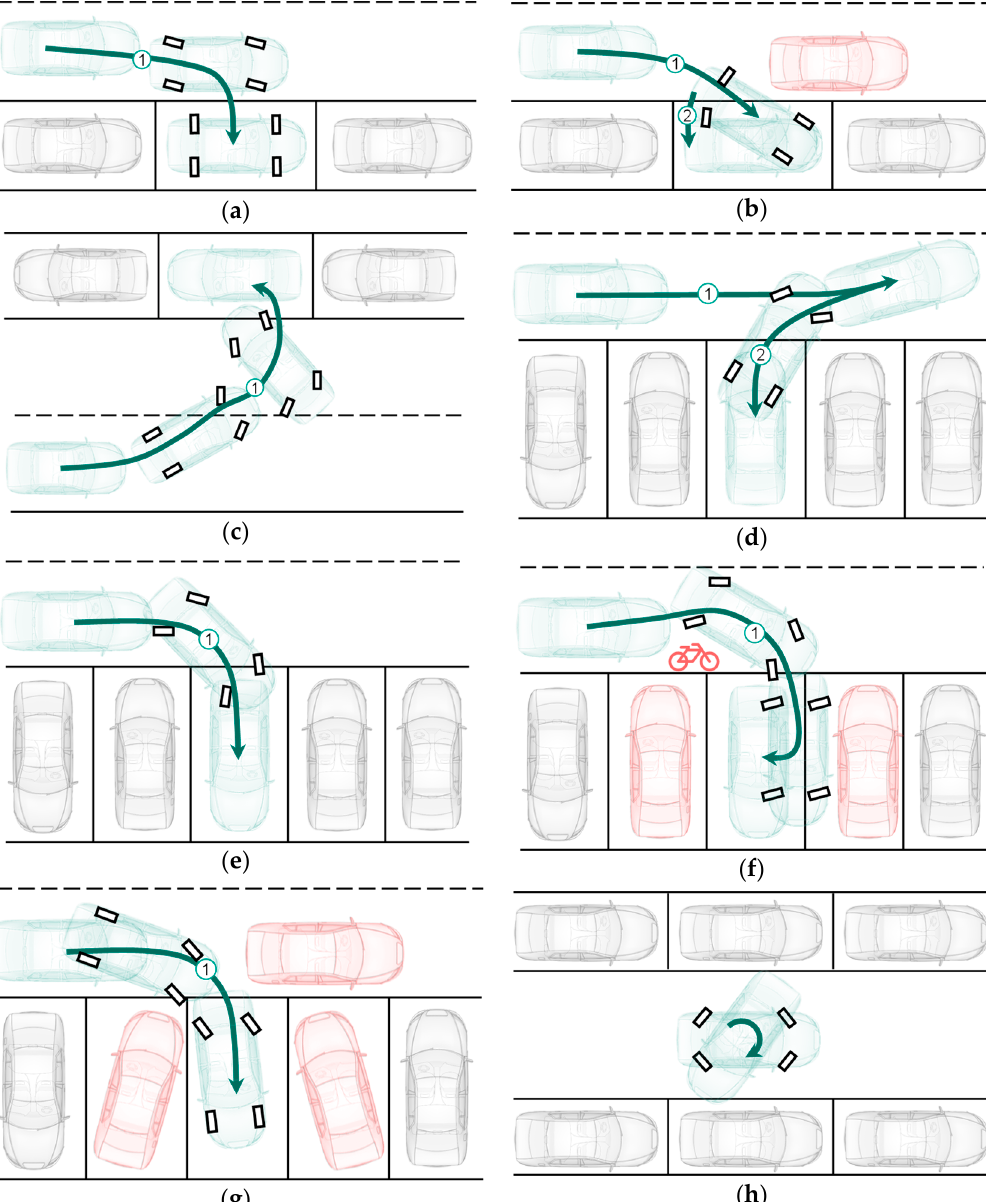
Figure 15. Driving maneuvers considered. ( a ) DM1: Vehicle parks in the parking lot without turning or stopping, 90° steering angle on each wheel can be realized; ( b ) DM2: Vehicle moves forward into the parking lot and the rear part of the vehicle is then pulled out. ( c ) DM3: Vehicle parks directly on the opposite side of the street without stopover; ( d ) DM4: Conventional reversing parking method; ( e ) DM5: Vehicle parks in a parking lot by steering the rear wheels in opposite directions to the front wheels; ( f ) DM6: Similar to DM5, but with correction at the end position; ( g ) DM7: Vehicle moves forward into the parking lot and the rear part of the vehicle is then pulled out, to avoid the obstacle; ( h ) DM8: Vehicle turns on its own vertical axis.